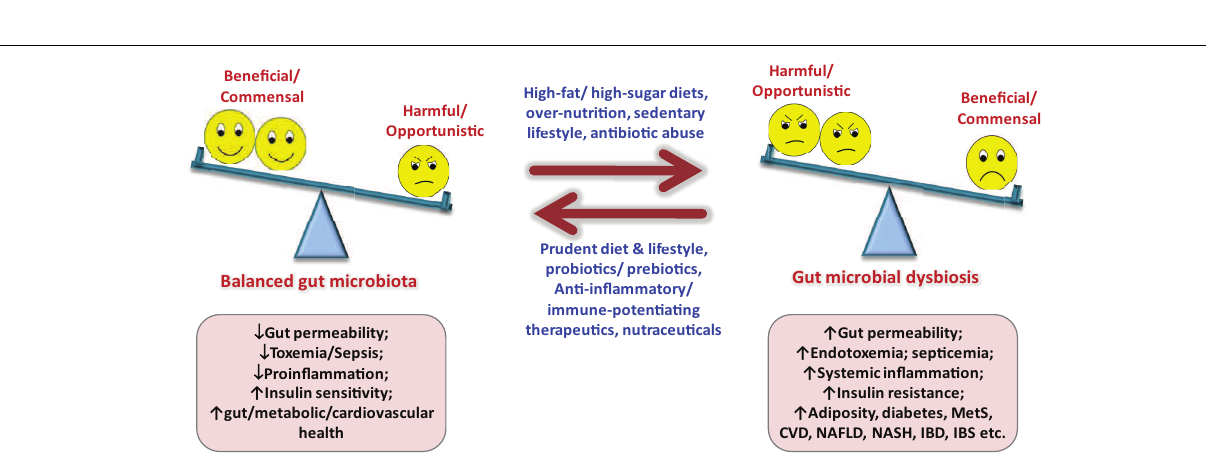
FIGURE 2 | Importance of balanced nutrition and gut microbiota, and consequences of gut dysbiosis . MetS, metabolic syndrome; NAFLD, non-alcoholic fatty liver disease; NASH, non-alcoholic steatohepatitis; IBD, inflammatory bowel disease; IBS, irritable bowel syndrome; CVD, cardiovascular